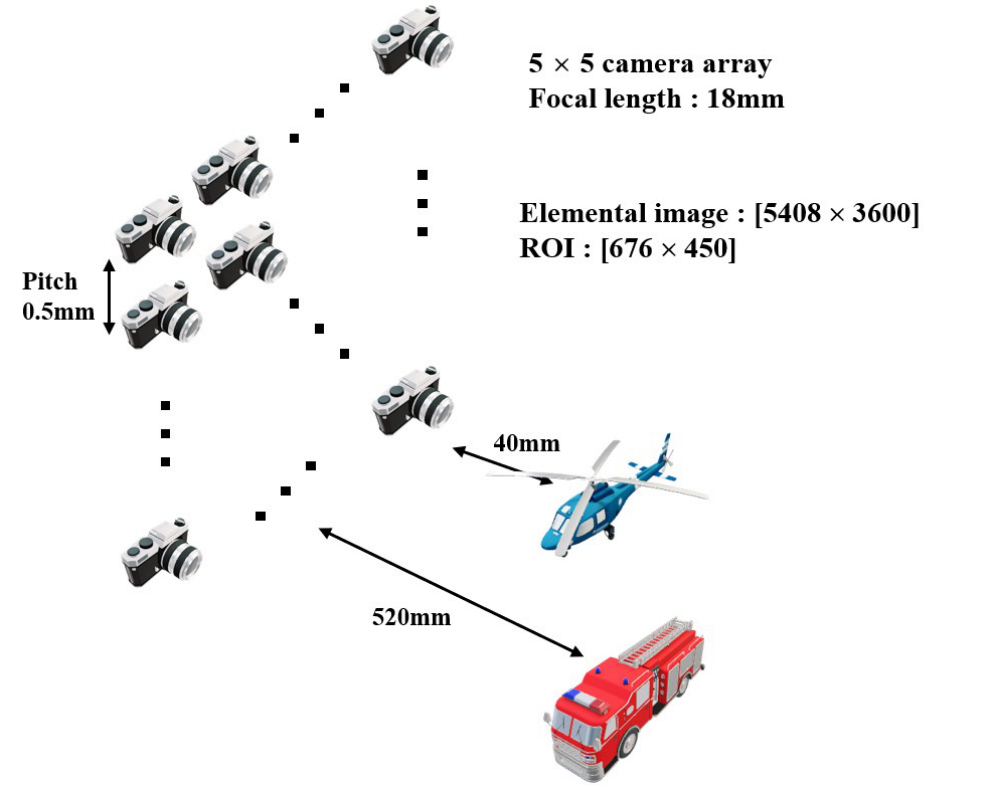
Figure 6. Experiment